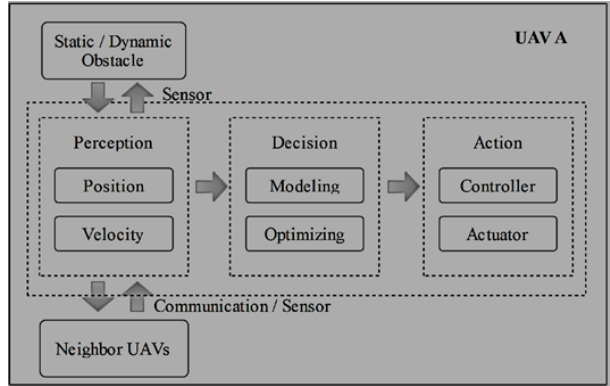
Figure 4. Self-Organizing Decision-Making